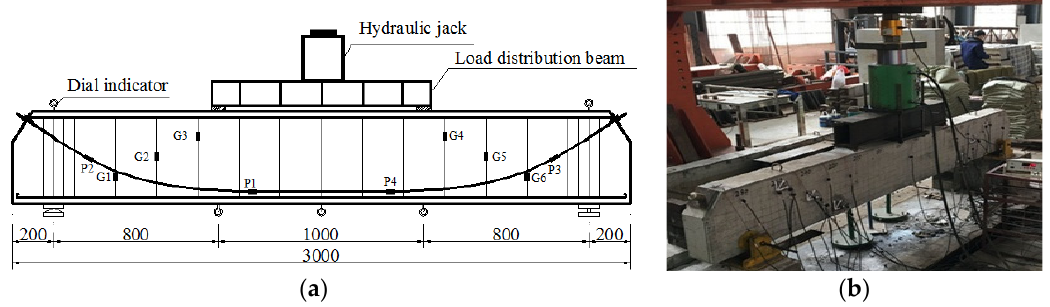
Figure 2. Loading diagram and measuring point layout. ( a ) Loading and measuring point layout (unit: mm), ( b ) Loading photo. Table 2. Corrosion time and corrosion rate η .